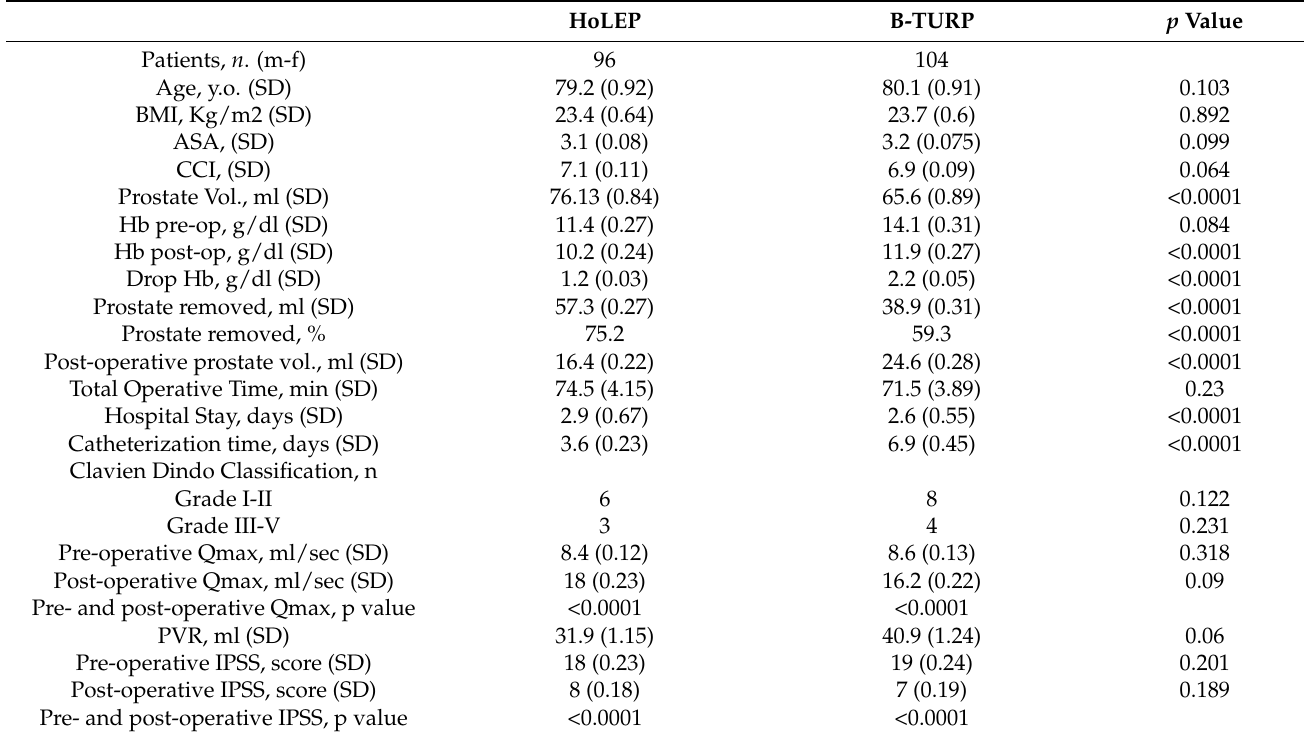
Table 1. Pre-operative and post-operative